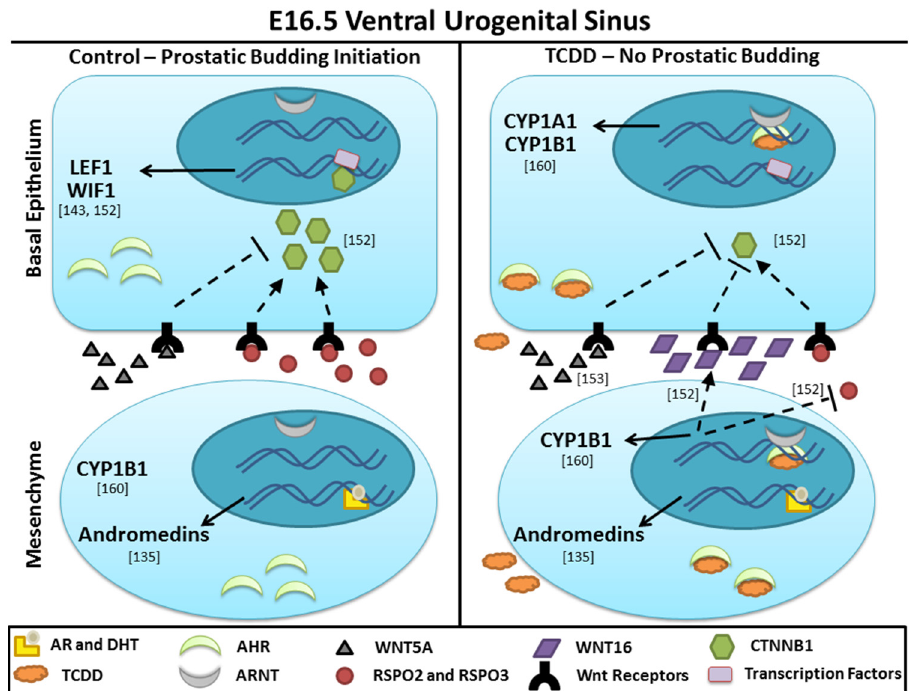
Figure 7. Hypothetical mechanism by which TCDD-induced activation of AHR